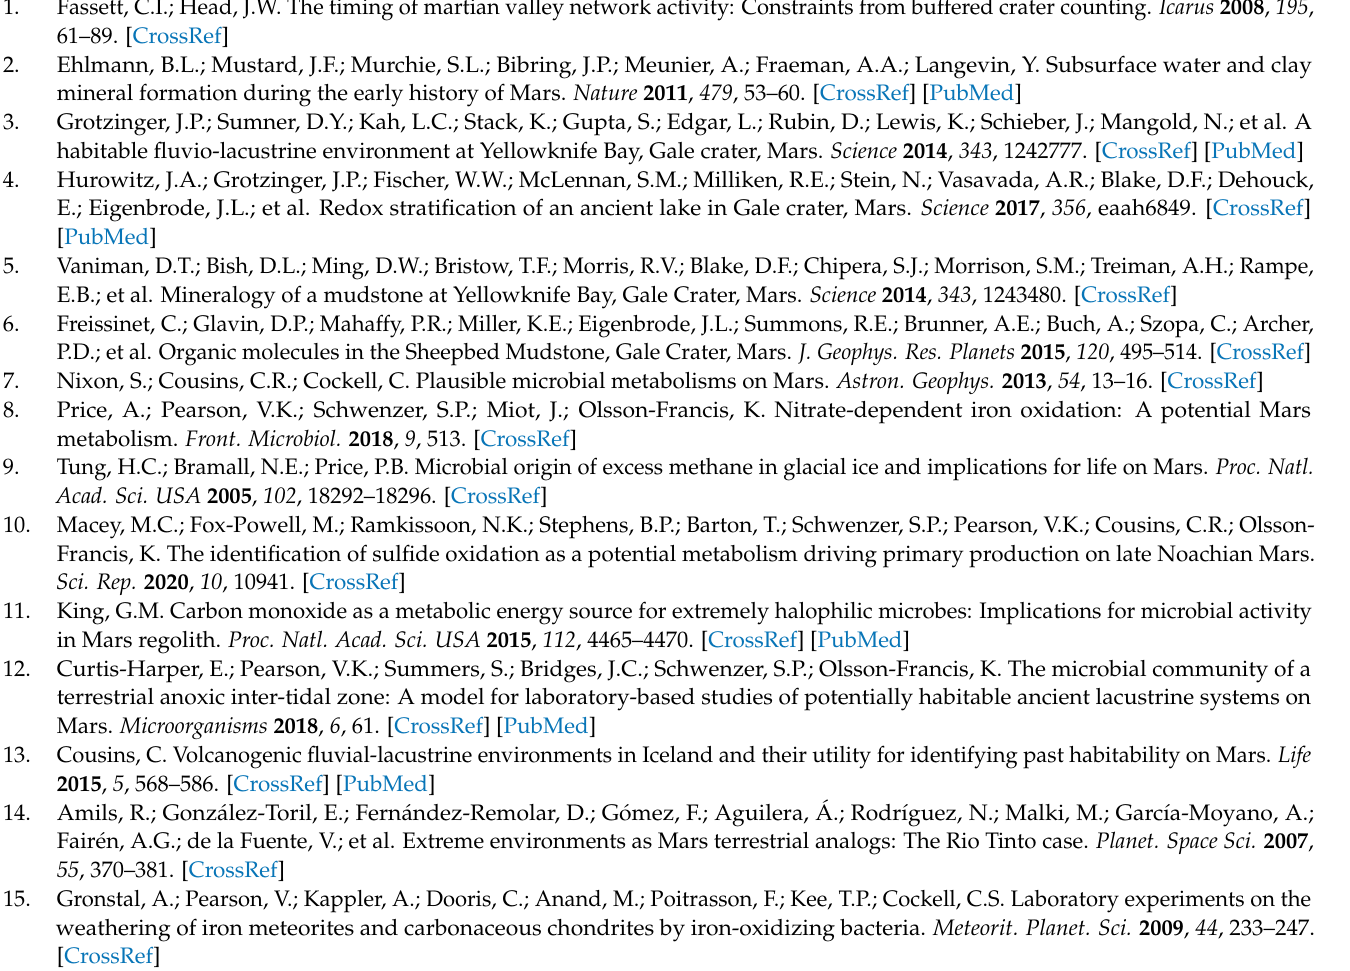
at p O 2 of 0.01, 0.2, 2, and 20 mbar.